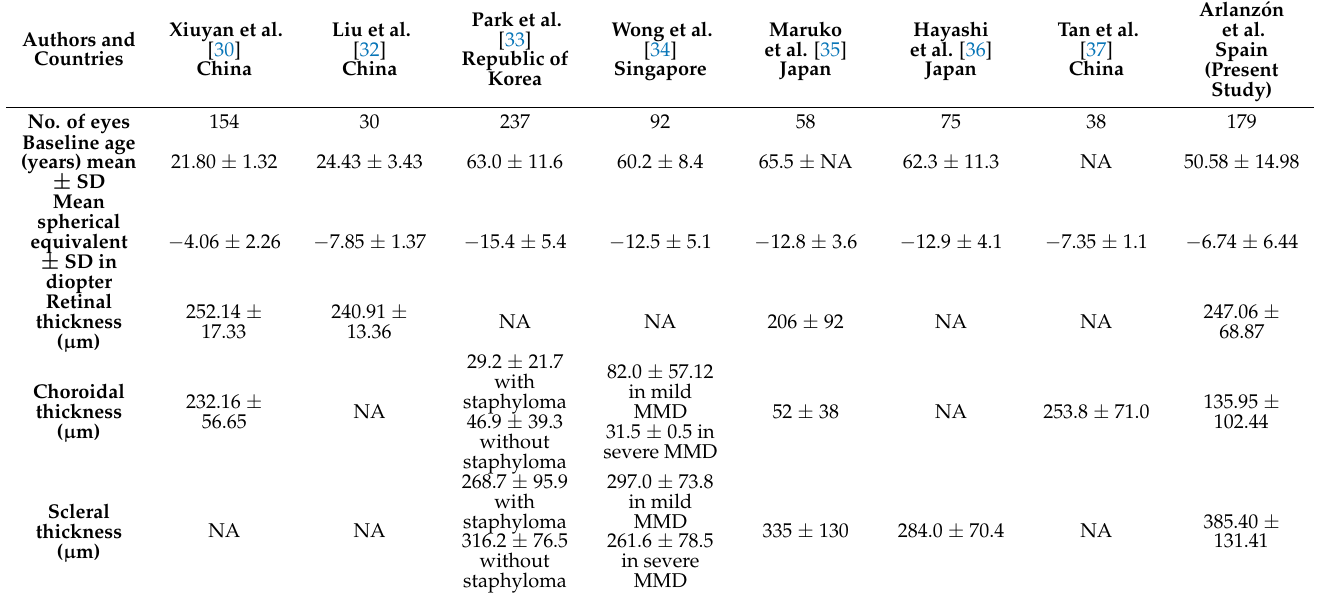
Table 4. Comparison of Retinal, Choroidal and Scleral Layer Thicknesses among Different